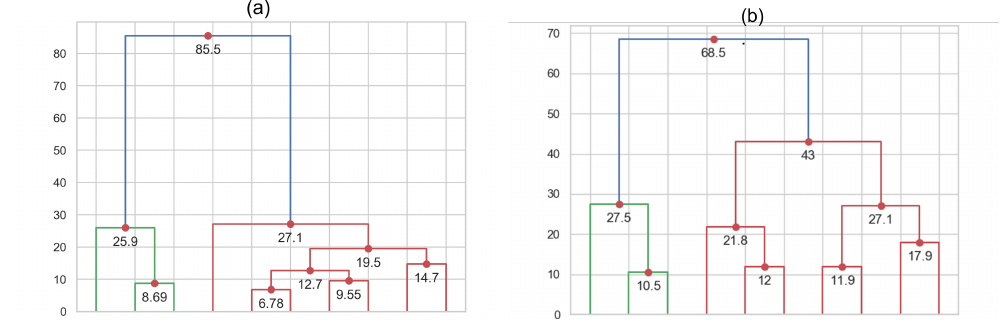
Figure 3. ( a ) Dendrogram of sample 10; ( b ) dendrogram of sample